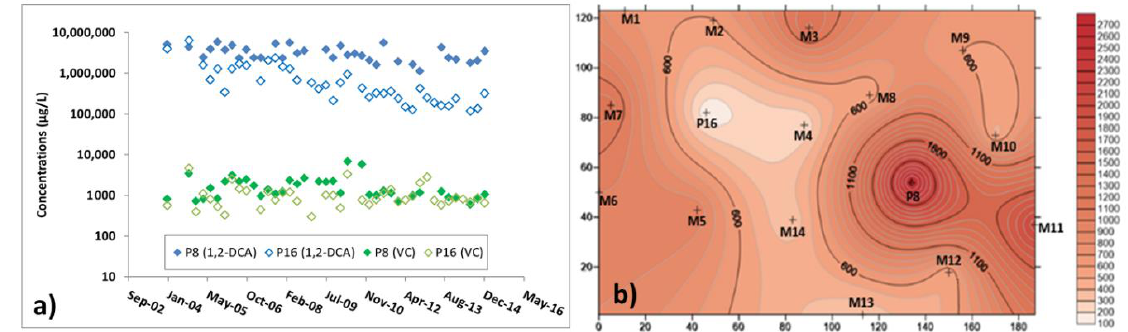
Figure 2. 1,2-dichloroethane (1,2-DCA) and vinyl chloride (VC) concentrations during the monitoring period from 2004 to 2013 for P8 and P16 ( a ). The absence of VC formation confirms a dihaloelimination mechanism; map distribution of 1,2-DCA concentration (mg/L) during the sampling campaign in 2015 ( b )).